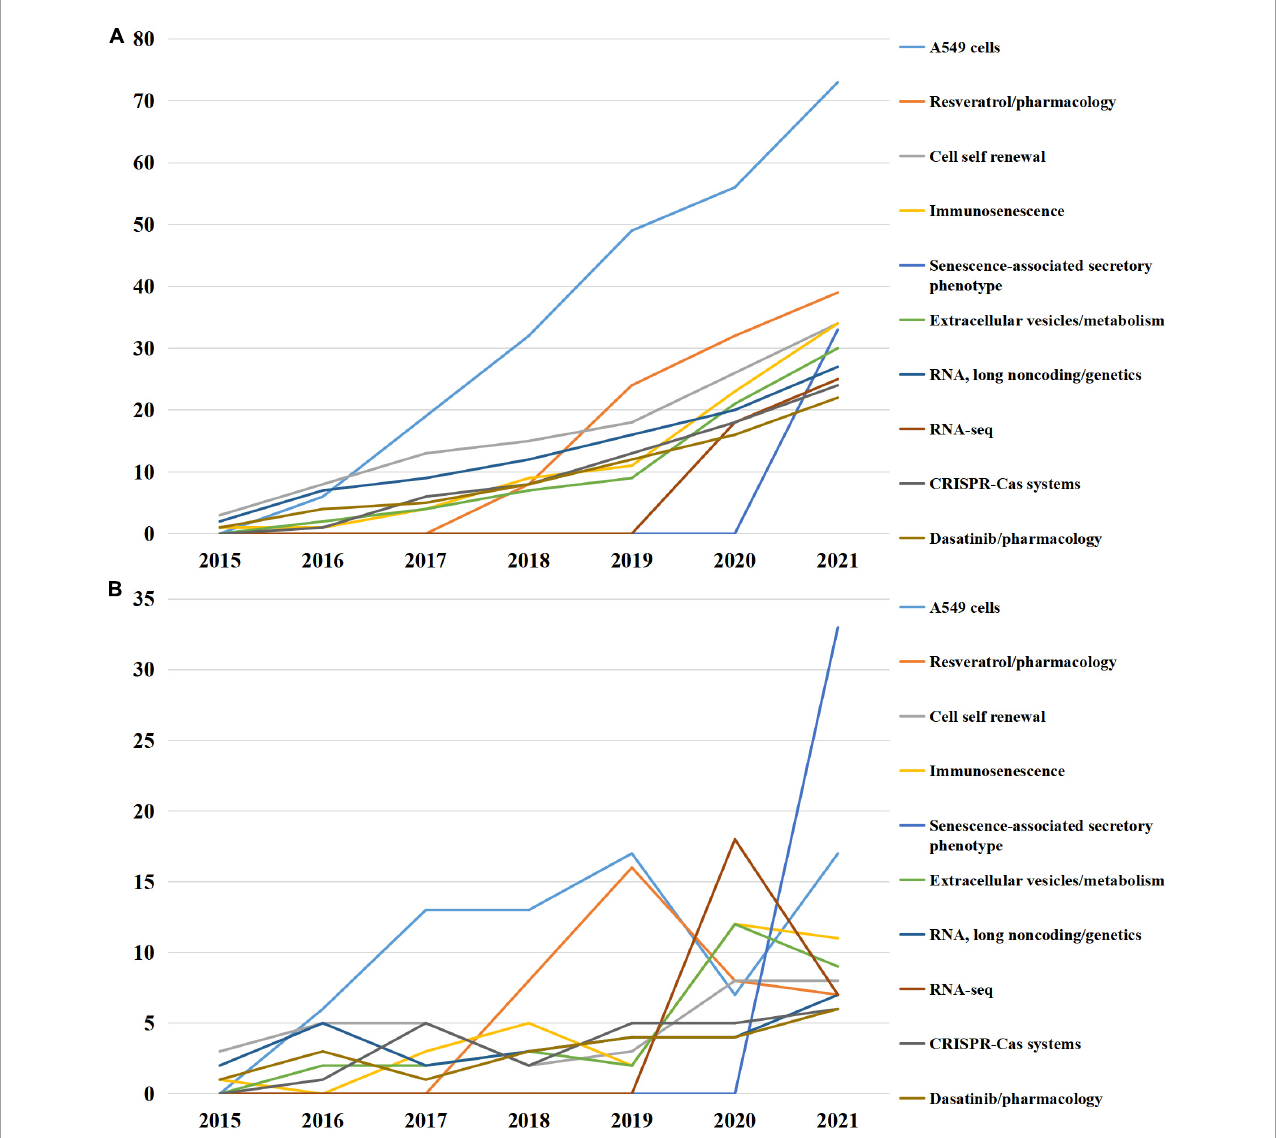
FIGURE5 Top 10 medical subject headings (MeSH) terms emerging after 2015. (A) Accumulated occurrences; (B) annual